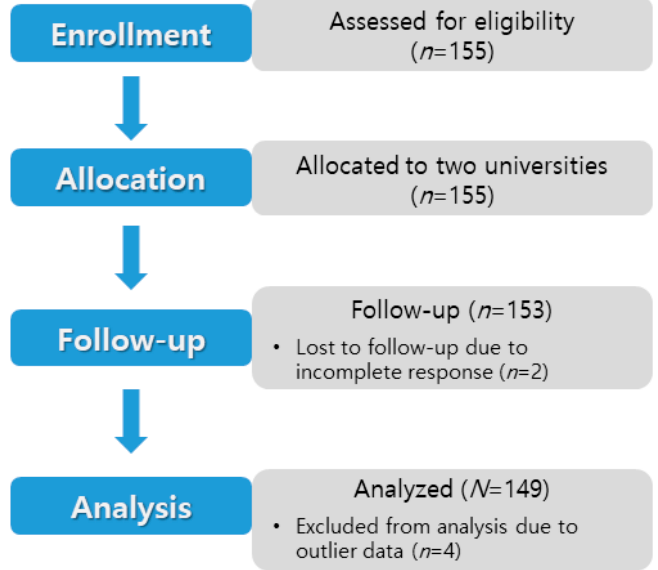
Figure 1. Flow diagram of data collection in this study.